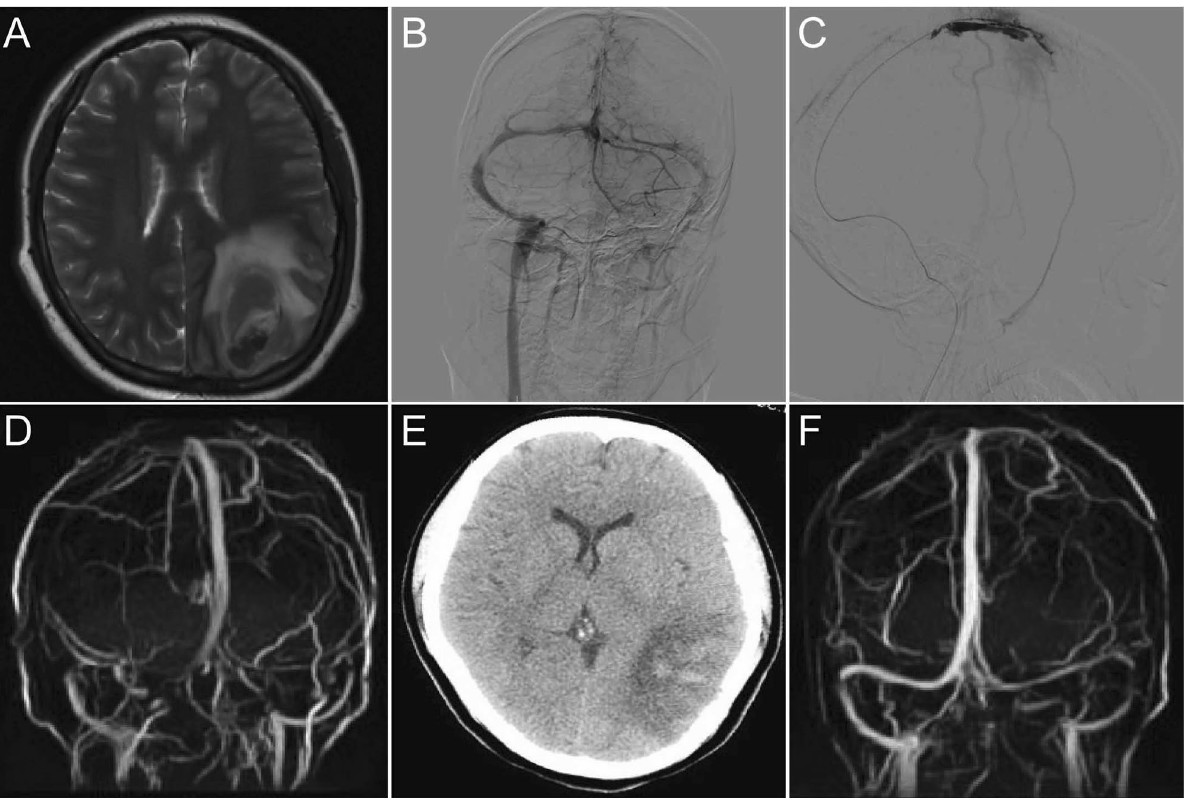
Figure 3. A representative 22-year-old female with CVST. MRI and DSA showed thrombosis of the superior sagittal sinus and left transverse sinus, accompanied by hemorrhage of the left occipital lobe ( A , B ). The intrasinus thrombolysis were performed ( C ). One week later, MRV showed recanalization of the superior sagittal sinus and the left transverse sinus ( D ), and CT scan showed absorption of hematoma ( E ). MRV showed complete recanalization of the superior sagittal sinus and the left transverse sinus at 3 months follow-up ( F